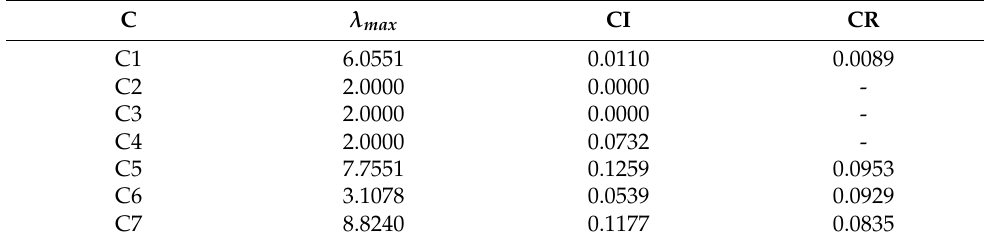
Table 2. C1–C7 consistency test results.